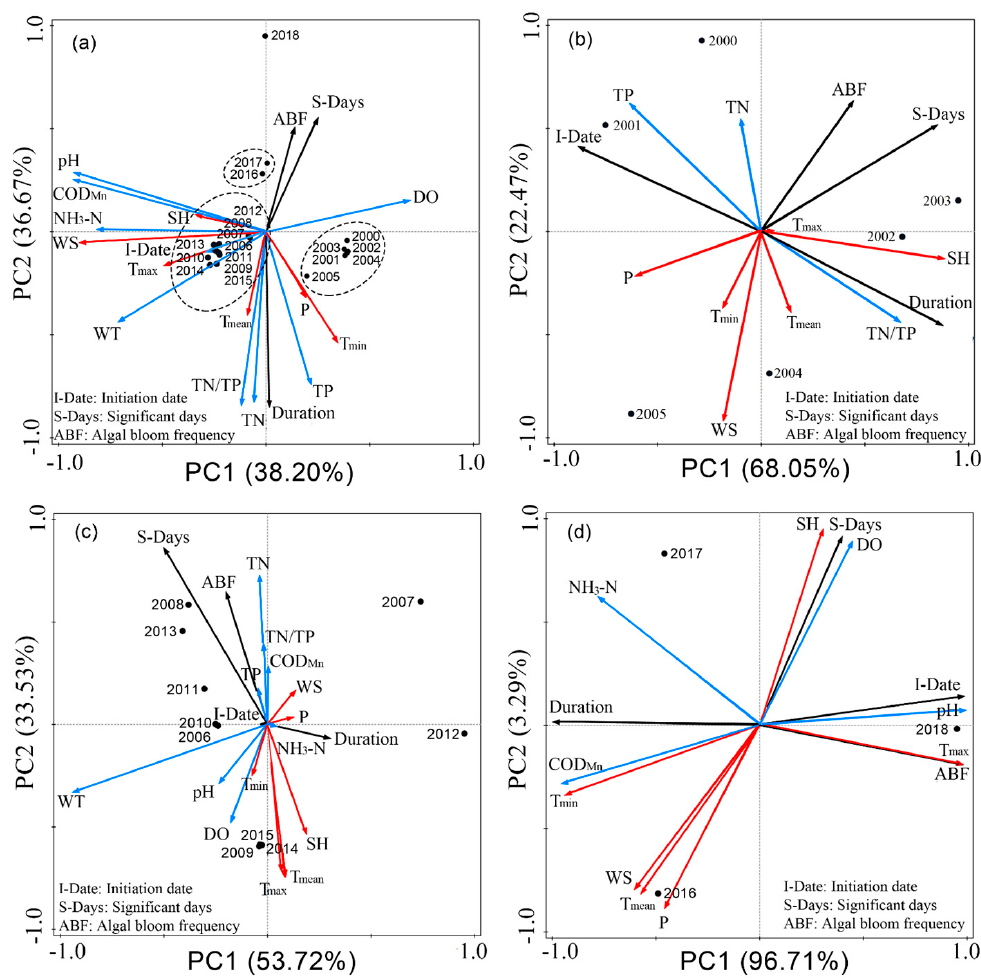
Figure 17. PCA ordination diagram of interannual algal blooms in Lake Dianchi. ( a ) 2000–2018; ( b ) 2000–2005; ( c ) 2006–2015; and ( d ) 2016–2018. Black points, interannual algal bloom variables; black arrows, algal bloom variables; red arrows, meteorological parameters; and blue arrows, water quality parameters.